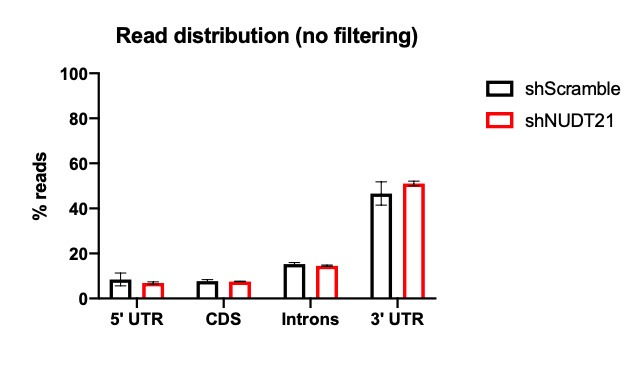
About 50% of unfiltered PAC-seq reads are in the 3′ UTR.